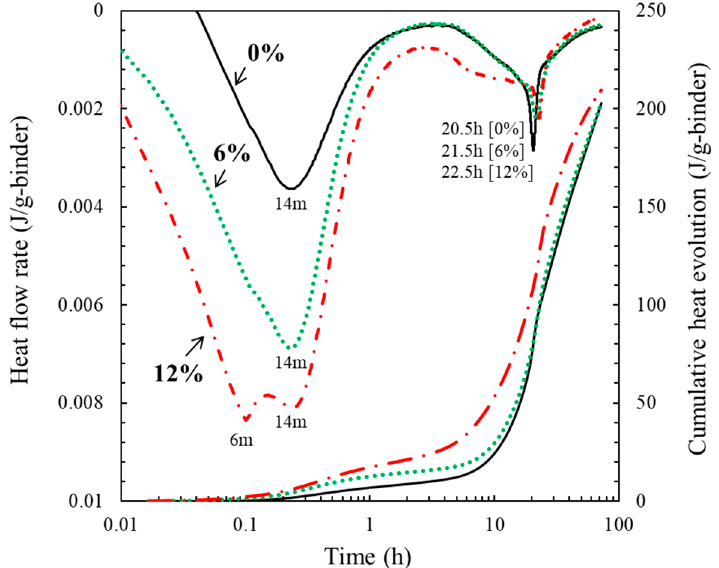
Figure 4. Isothermal conduction calorimetry of cement mortar incorporating calcined oyster shell powders of 0%, 6%, and